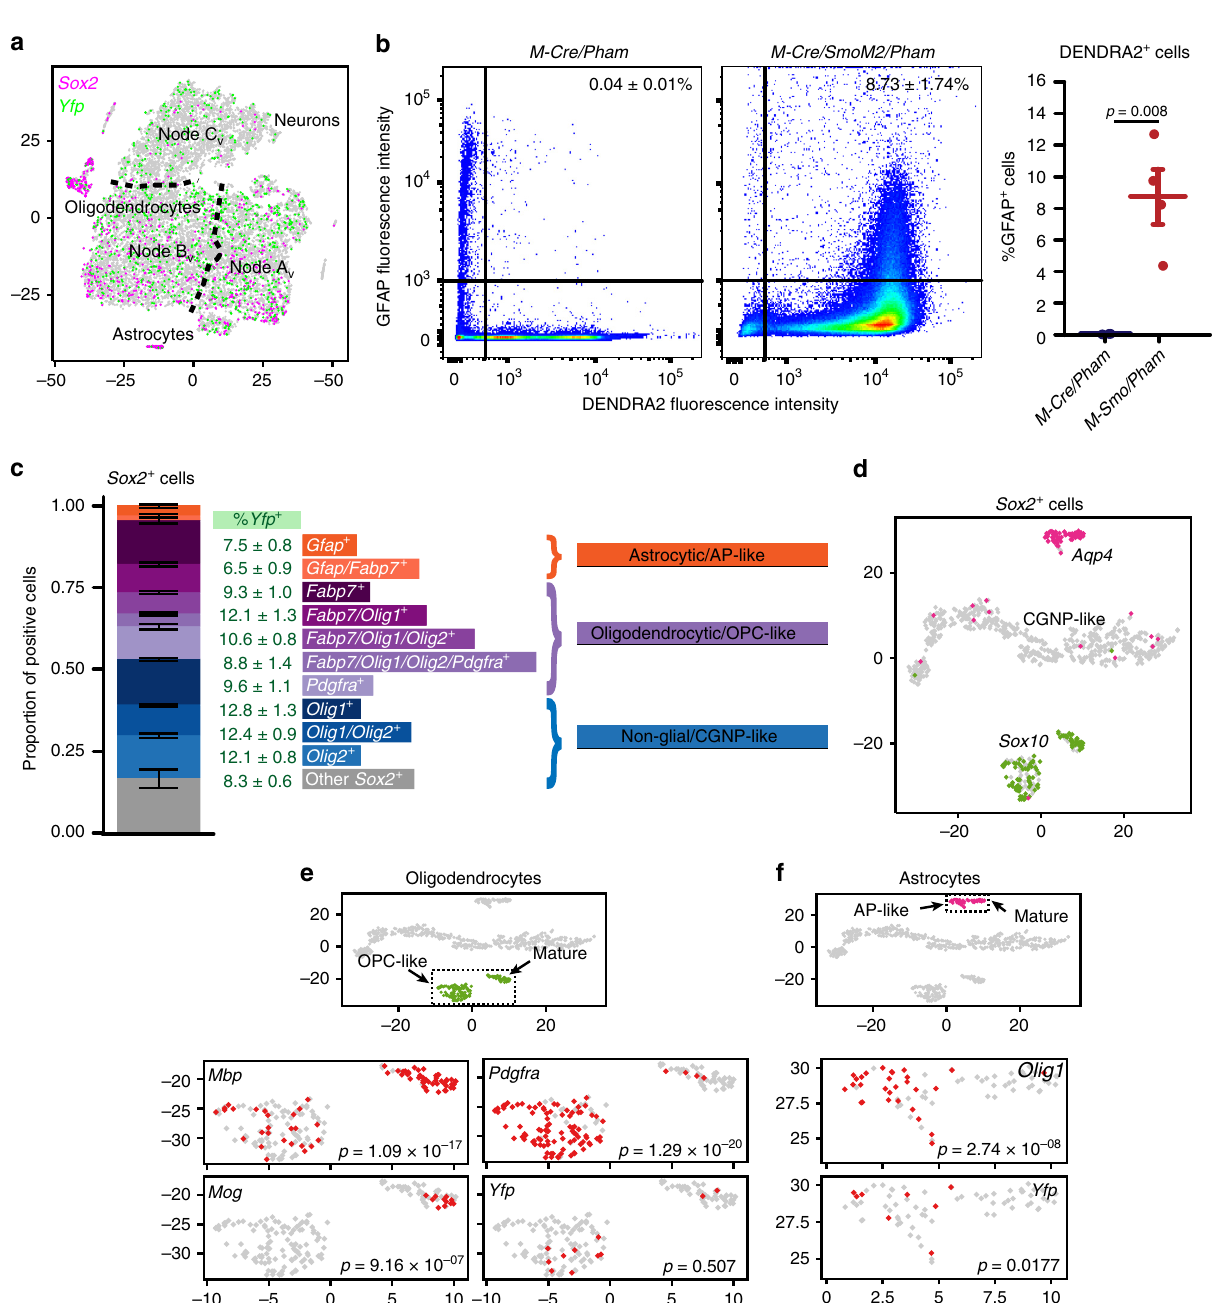
Fig. 5 Tumors show lineage expansion and stem cell marker expression. a Feature plot of Sox2 and Yfp on the t-SNE projection of Fig. 2a. b Representative fl ow cytometry studies, plotting GFAP expression of each cell versus DENDRA2 expression, with thresholds for positivity indicated by solid lines, and with the fraction of GFAP + cells in the DENDRA2 + cerebellar or tumor populations of replicate mice of indicated genotypes. c Bar plot showing the proportions of Sox2 + cells expressing indicated markers in each of the fi ve vehicle-treated tumors. Error bars are SEM. d t-SNE projection of Sox2 + cells from the fi ve vehicle-treated tumors, directed by ICA, with feature plots of Sox10 and Aqp4 . e Oligodendrocytic clusters of the t-SNE projection in d , with feature plots of Pdgfra , Mbp1 , Plp1 , Mog and Yfp . f Astrocytic clusters of the t-SNE projection in d , with feature plots of Olig1 and Yfp . p Value in b determined by two-sided Student ’ s t -test and in e and f , by Fisher ’ s exact